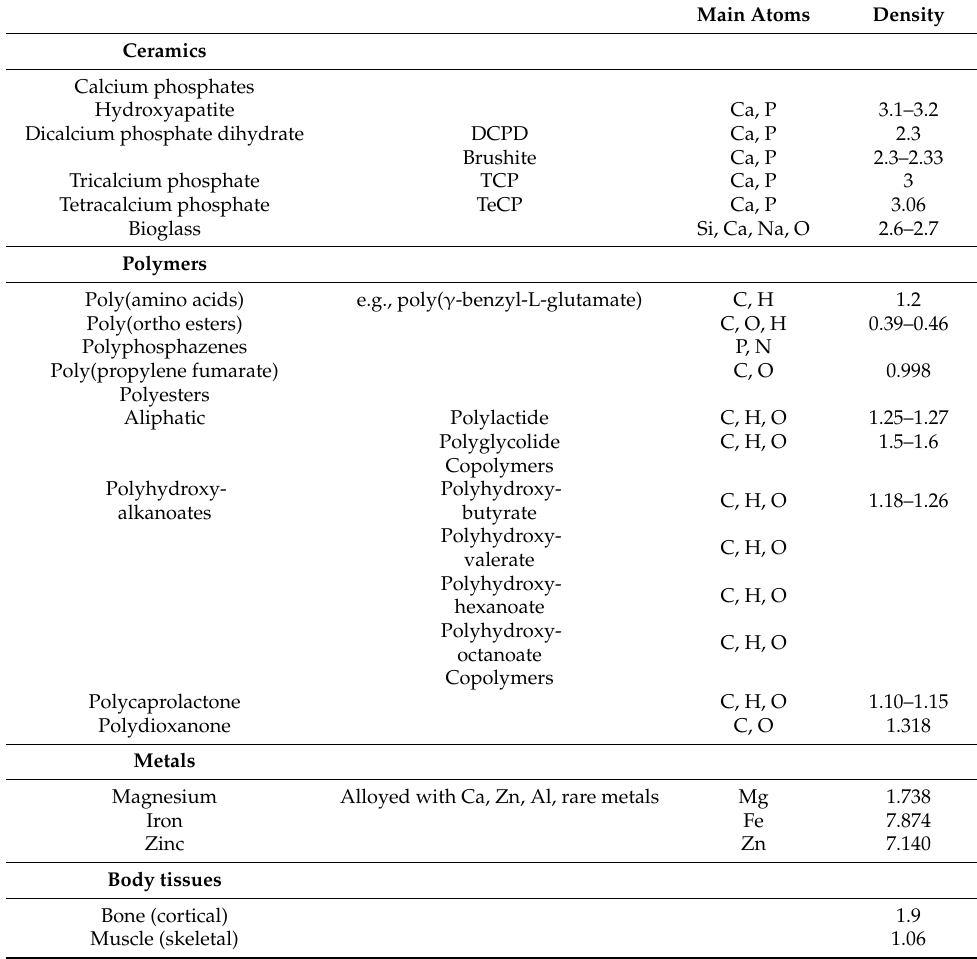
Table 1. Biodegradable implant materials reported in the literature, the main constituent atoms and average density